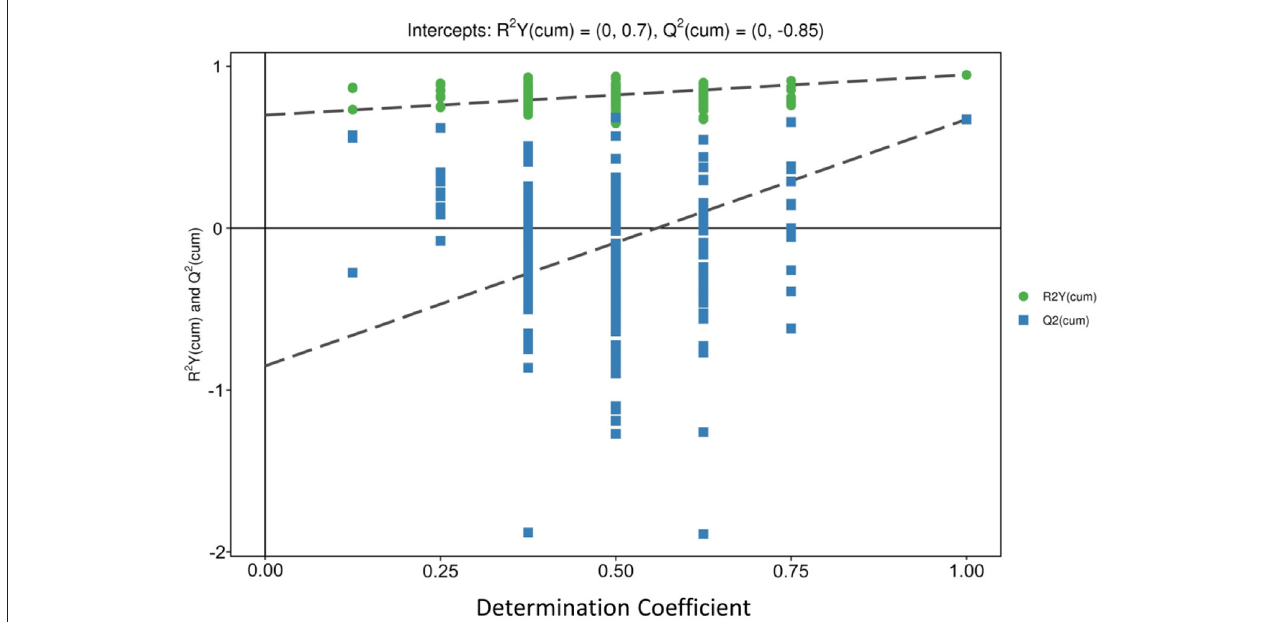
FIGURE 4 | Permutation test of OPLS-DA model for Pinggu group vs. Shunping